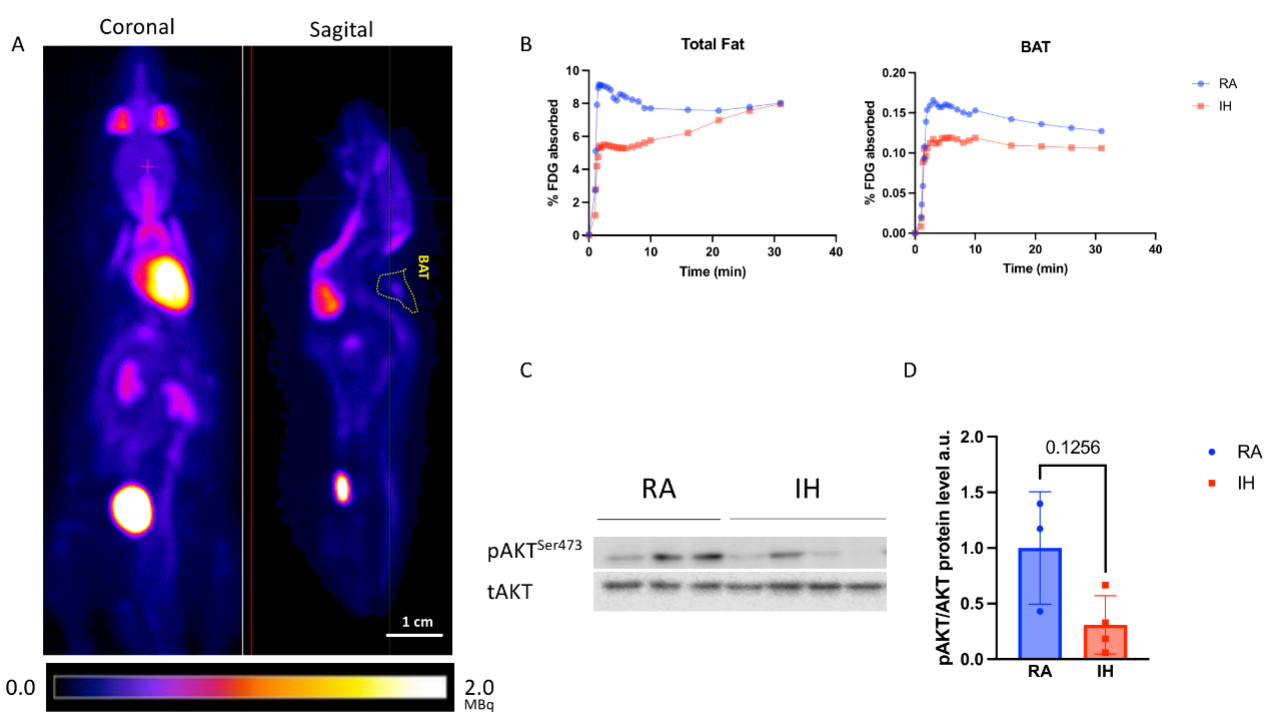
Figure 6. Chronic intermittent hypoxia promotes BAT-specific insulin resistance. ( A ) Representative 18 F-Fluorodeoxyglucose (FDG) absorption images demonstrating the anatomical location of BAT. ( B ) Quantification of the 18 F-FDG consumption in total fat, demonstrating reduction in IH, compared with RA in total body fat (left panel) and BAT (right panel) ( n = 3–5). ( C , D ) Western blot analysis of phosphorylated AKT(Ser473) protein levels normalized to total AKT in BAT following i.p. insulin stimulation ( n =